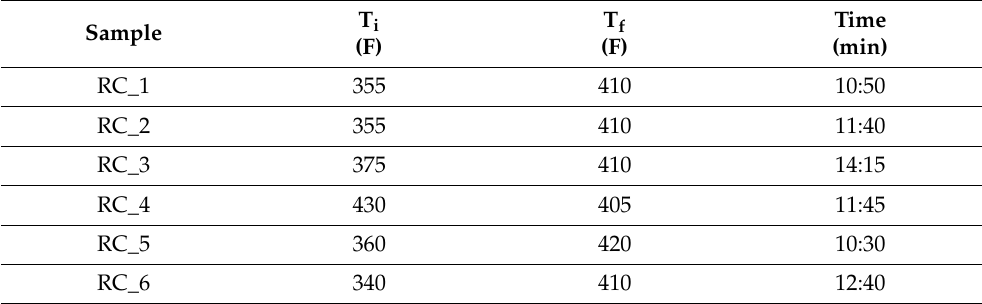
Table 2. The parameters of roasting process for investigated coffee beans—initial roasting temperature (T i ), final roasting temperature (T f ) and